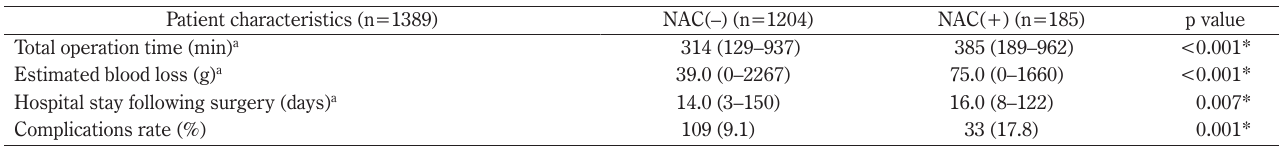
Table 2 Perioperative short-term outcomes in patients undergoing laparoscopic gastrectomy with or without NAC, before propensity score matching